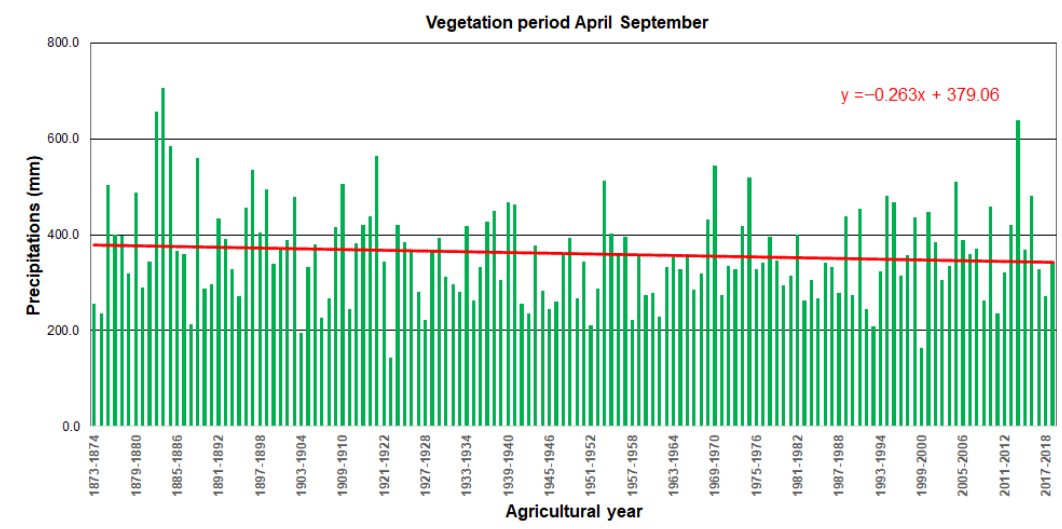
Figure 8. The evolution of rainfall during the warm period of the year in the Banat Plain over a period of 146 years (1873–2019).